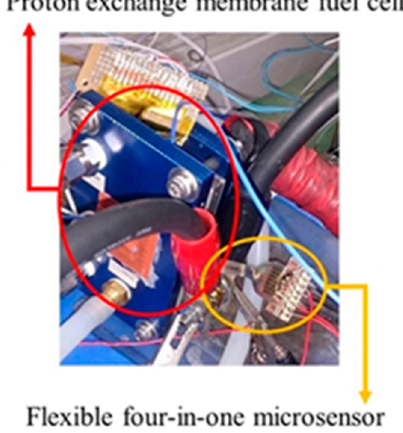
Figure 10. Stereogram of fuel cell embedded with flexible four-in-one microsensor.